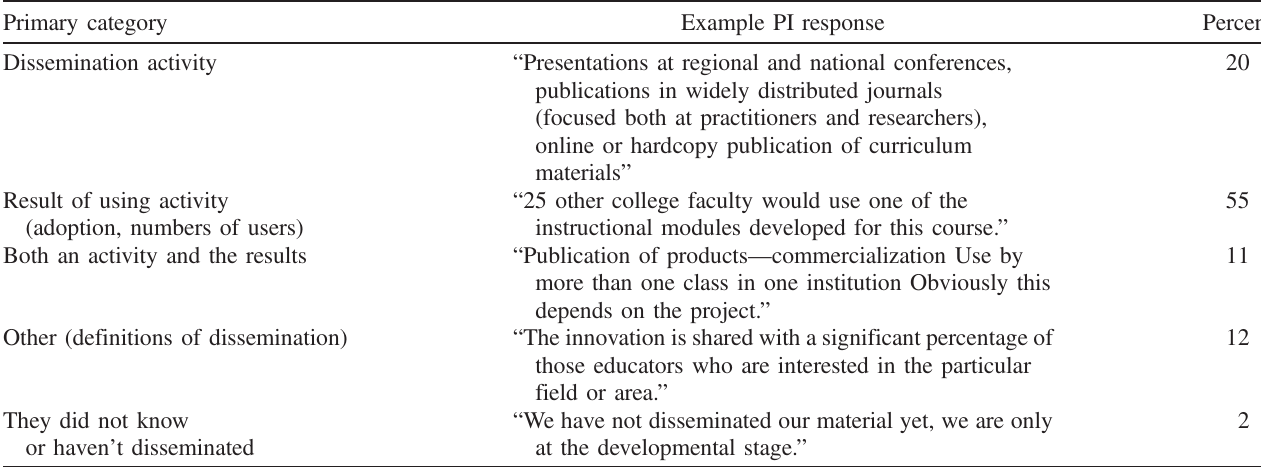
TABLE I. Example PI responses to question 7 and coding, adapted from Ref. [23]. Primary